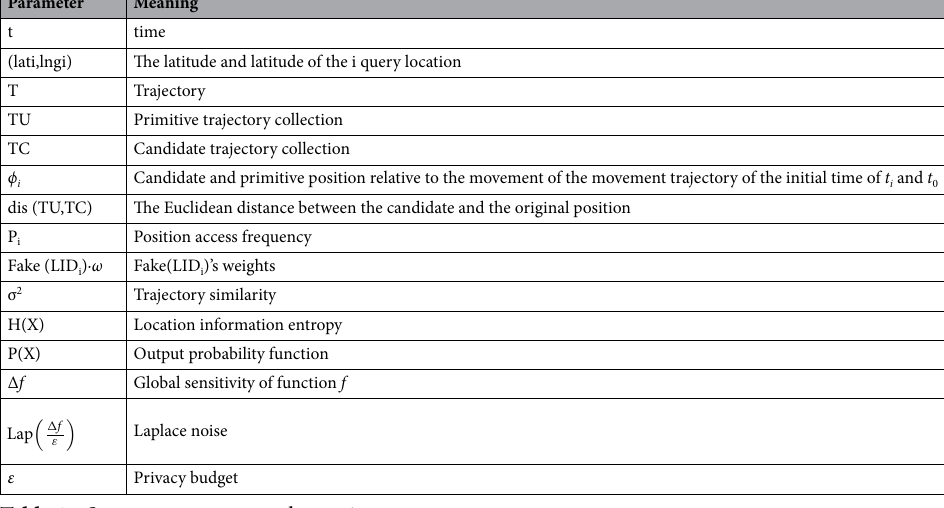
Table 1. System parameters and meaning.